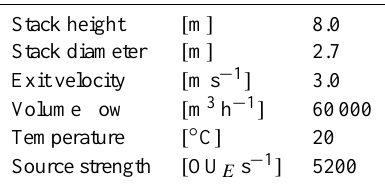
Table 2. Source data for dispersion calculations with